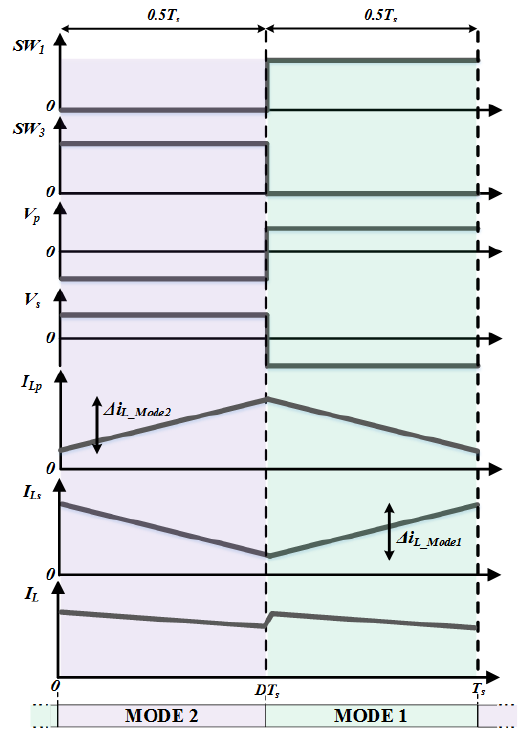
Figure 5. Switching scheme of proposed VB under pattern 1; steady state.